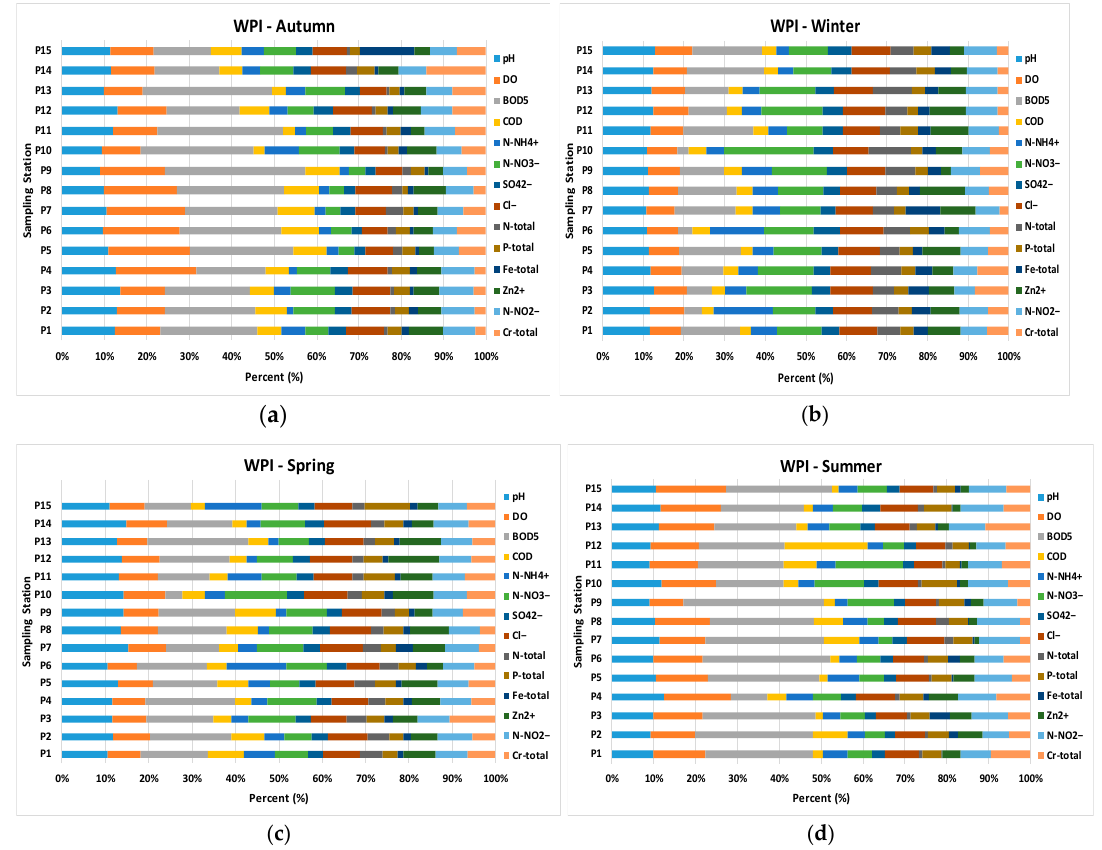
Figure 6. The weight of each parameter to the WPI values recorded in autumn ( a ), winter ( b ), spring ( c ) and summer ( d ).